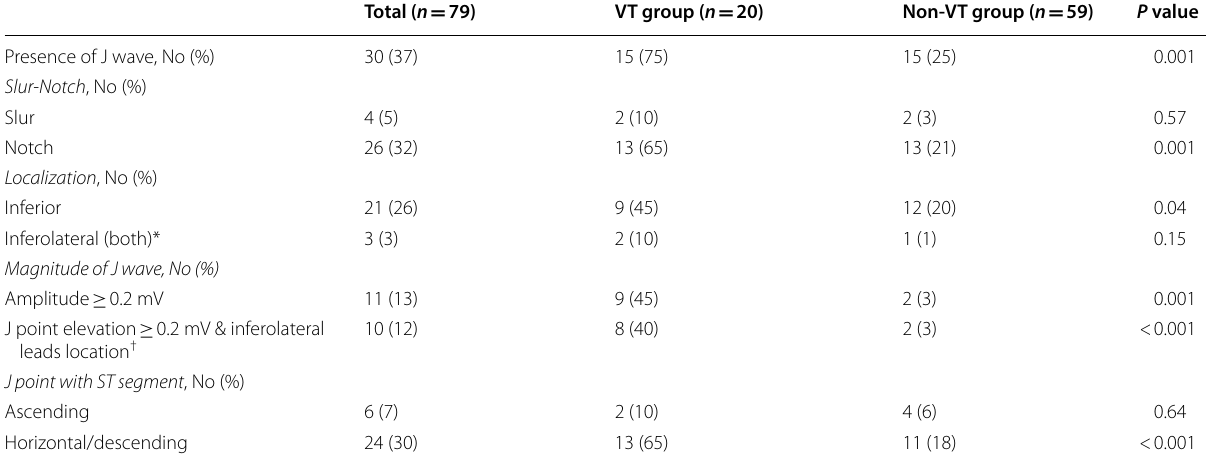
Values are mean SD or number (%); VT ventricular tachycardia; Inferolateral * J wave in at least two inferior leads and in two lateral leads; Inferolateral location † J wave ± in at least two inferior leads or in two lateral leads, or both